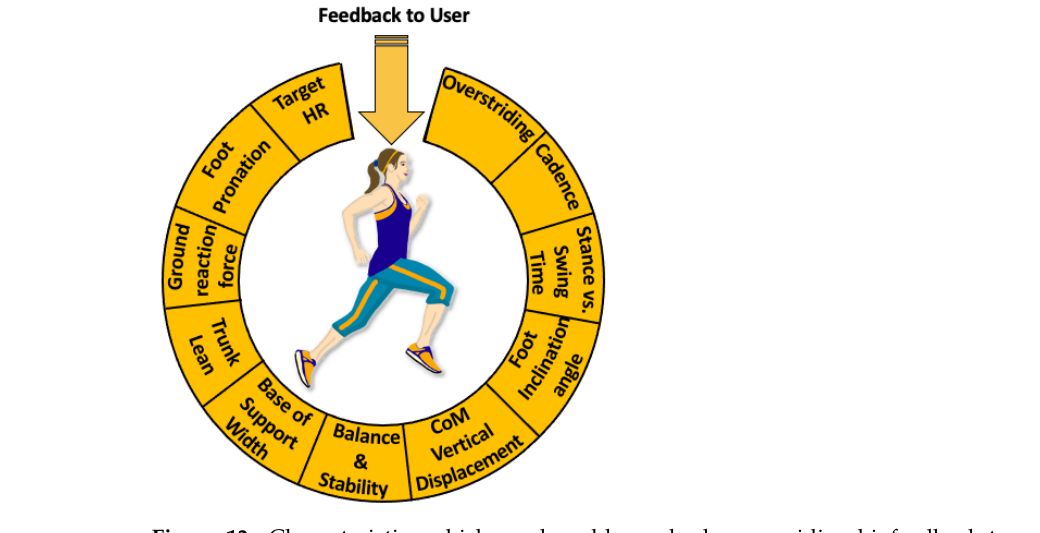
Figure 13. Characteristics which can be addressed when providing biofeedback to a runner in order to reduce the risk of injury when running, in addition to monitoring and improving running performance and health.